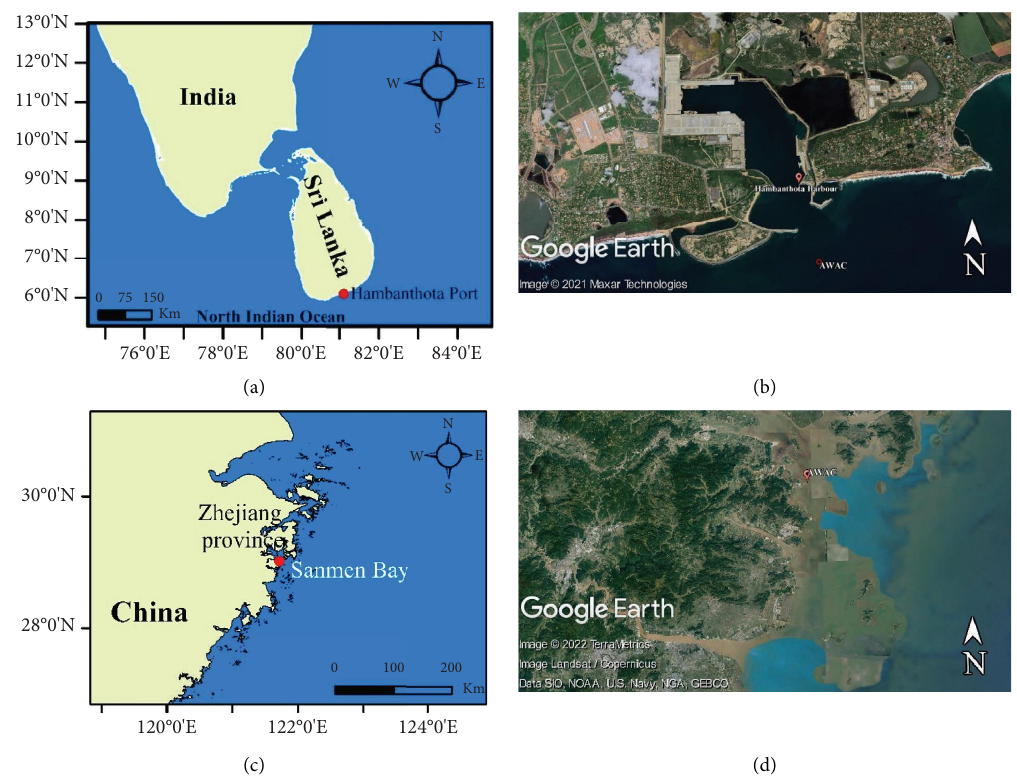
Figure 1: Study area. (a and b) Hambantota Port, Sri Lanka; (c and d) Sanmen Bay,